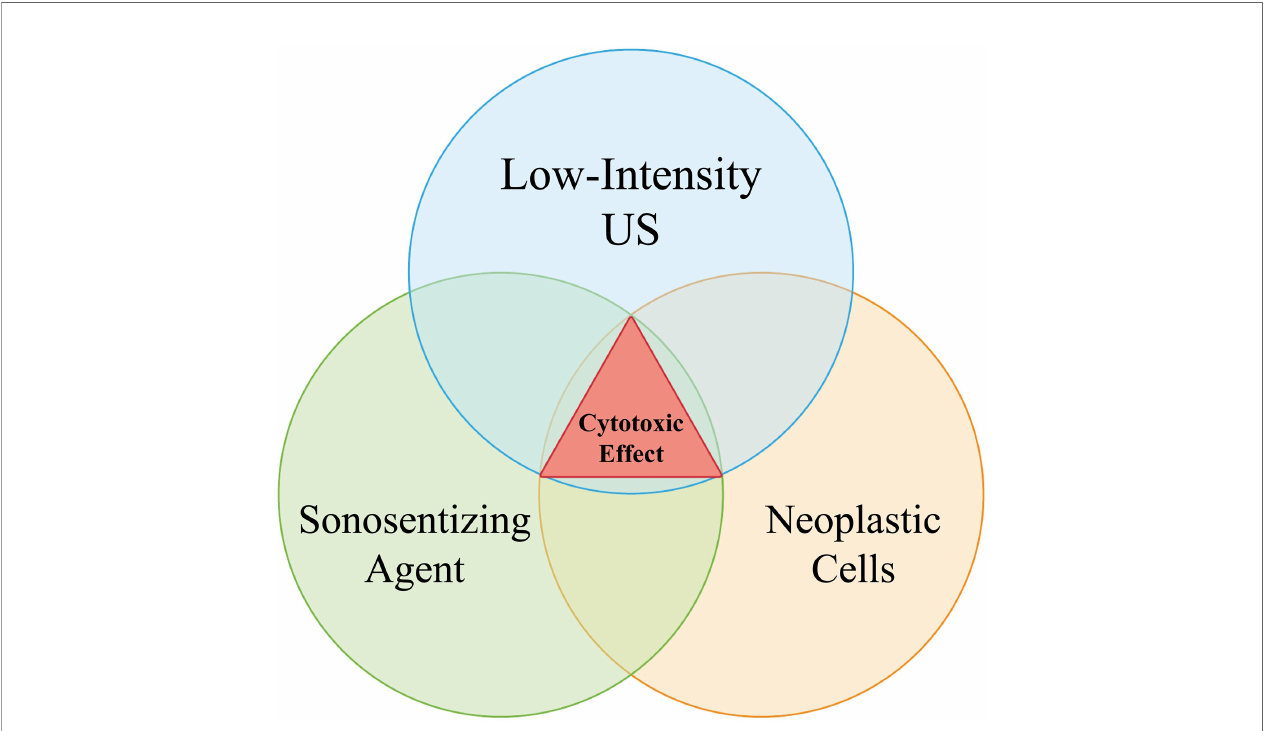
FIGURE 6 | The Venn Diagram explains the relation between sonosensitizer administration (5-ALA or Na-Fl), low-frequency sonication and tumor presence. The contemporary presence of all the three aforementioned events is required for a cytotoxic process to verify. As “ tumor ” here it is meant any lesion which is able to properly locally concentrate the administered sonosensitizers, granting the onset of their biological effects once activated by sound